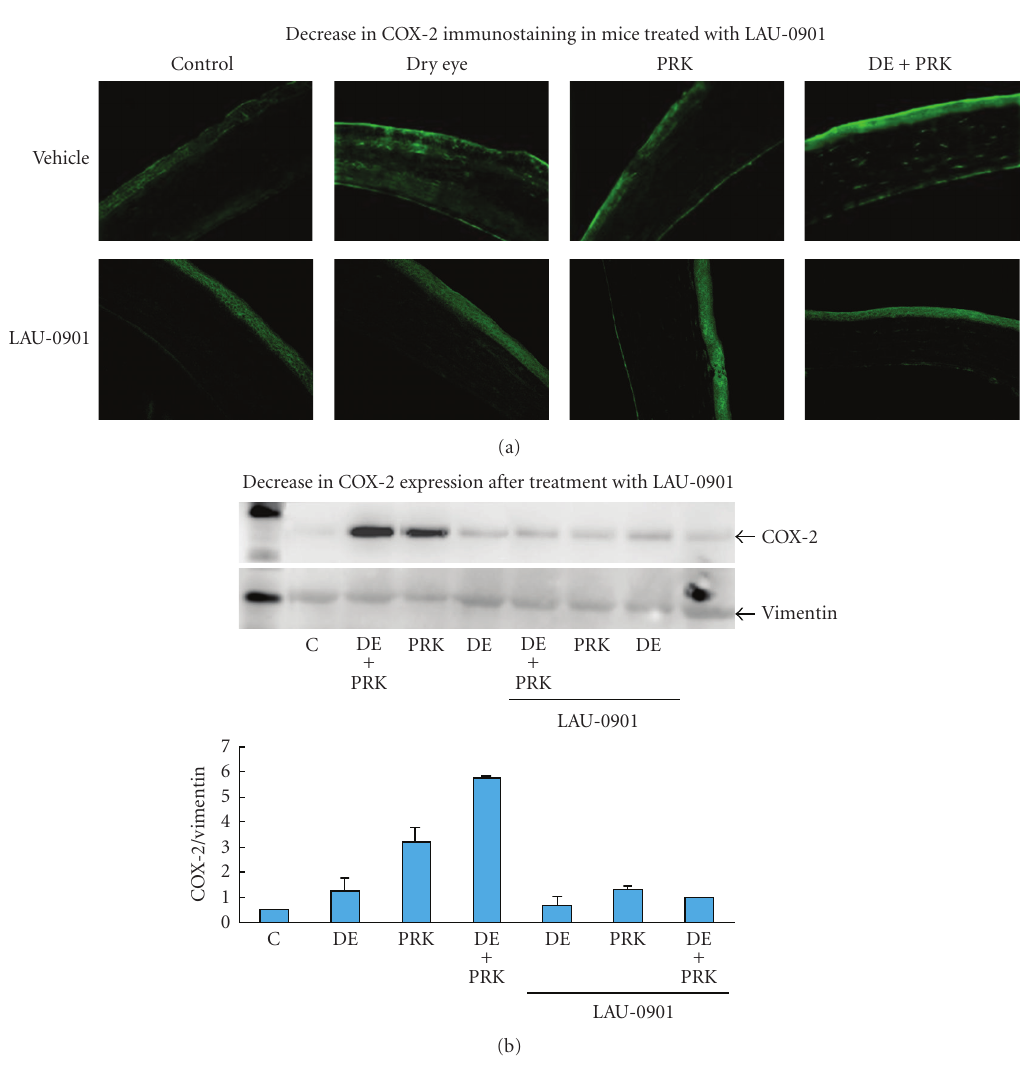
Figure 2: Significant decrease of COX-2 expression one week after PRK and exposure to desiccating conditions (DEs) in eyes treated with